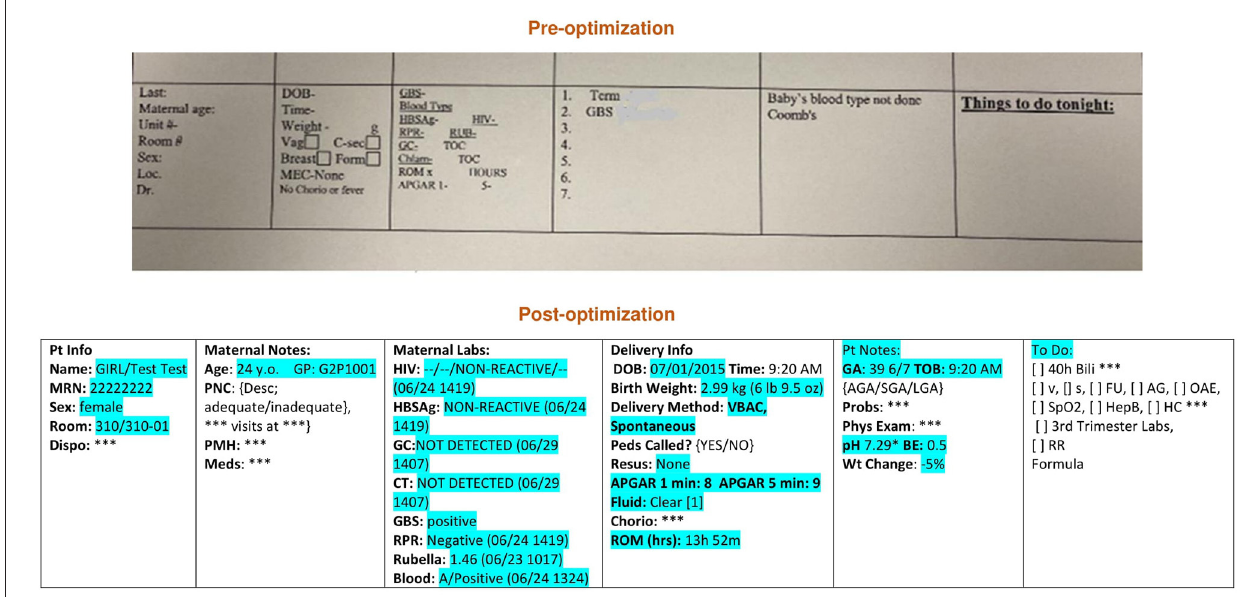
FIGURE 3 | Hand-off list pre and post optimization. Loc, Location; DOB, Date of birth; Vag, Vaginal; C-sec, Cesarean section; Mec, Meconium; HIV, Human immunodeficiency virus; HBSAg, Hepatitis B antigen; GC, Gonorrhea; Chlam, Chlamydia; GBS, Group B streptococcus; RPR, Rapid plasma reagin; RUB, Rubella; Chorio, Chorioamnionitis; ROM, Rupture of membranes Blue highlight, Auto generated data; ***, Manual entry of data required; {}, Pick list; Epic codes are omitted; Y.o., Year old; Pt, Patient; Info, Information; Dispo, Disposition; PNC, Prenatal care; PMH, Past medical history; Meds, Medications; CT, Chlamydia; GBS, Group B streptococcus; RPR, Rapid plasma reagin; DOB, Date of birth; VBAC, Vaginal birth after cesarean section; Peds, Pediatrics, Resus, Resuscitation; GA, Gestational age; TOB, Time of birth; AGA, Appropriate for gestational age; SGA, Small for gestational age; LGA, Large for gestational age; Probs, Problems; Phys, Physical; BE, Base excess; Wt, Weight; Bili, bilirubin; V, Void; S, Stool; FU, Follow up; OAE, Otoacoustic emissions; SpO2, Oxygen saturation; Hep B, Hepatitis B vaccine; HC, Head circumference; RR, Red